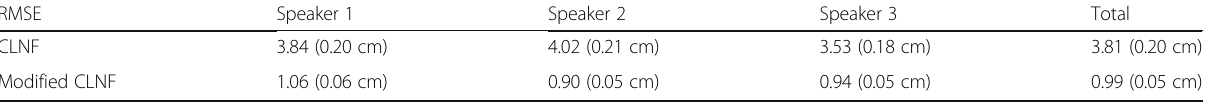
Table 2 RMSE values for original CLNF model and for Modified CLNF (expressed in pixels and in cm)